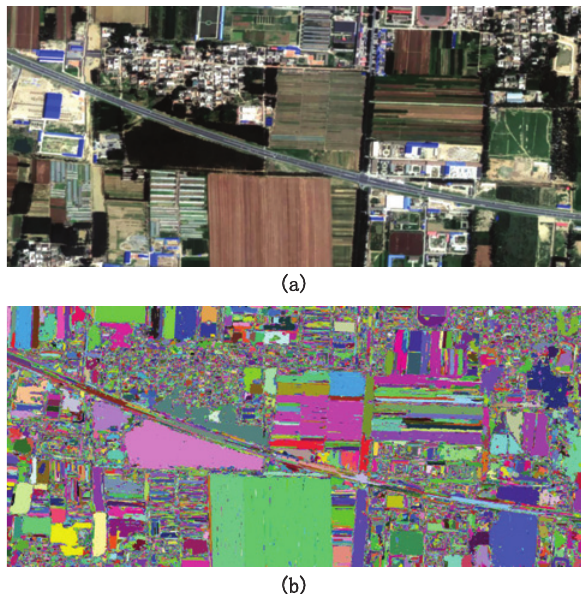
Figure 6. (a)First watershed iteration result (b)Second watershed iteration result